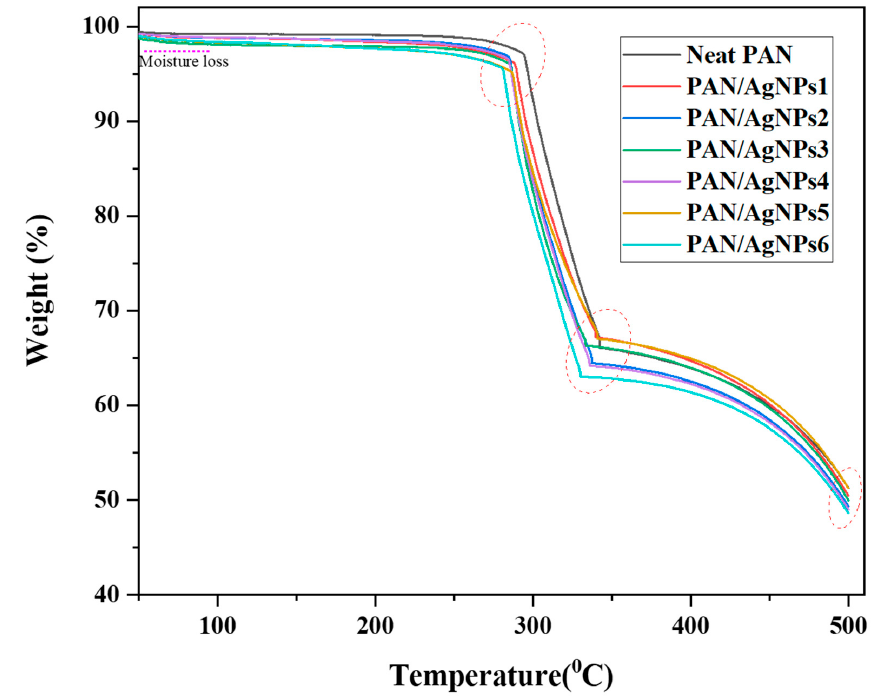
Figure 8. TGA analysis of PAN nanofiber, PAN/AgNPs1, PAN/AgNPs2, PAN/AgNPs3, PAN/AgNPs4, PAN/AgNPs5, and PAN/AgNPs6.